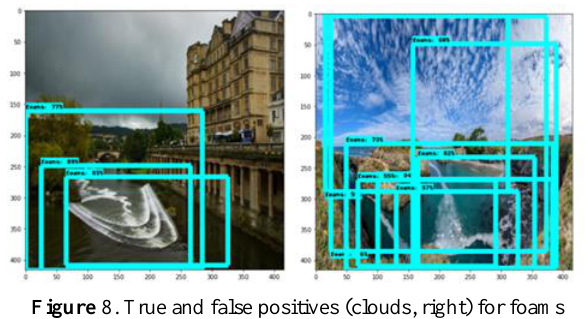
Figure 7. True positives for foams and algae (correctly detected and located)